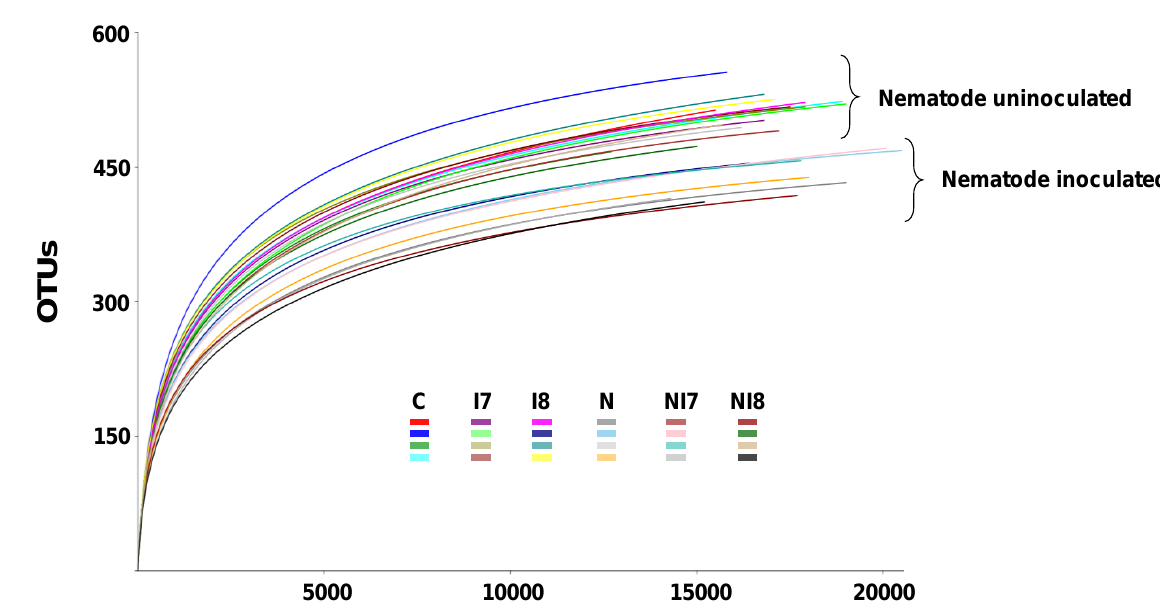
Figure 2. Operational taxonomic unit (OTU) rarefaction curves of the 16S rRNA sequence reads obtained revealing satisfactory sequencing depth to represent the pine rhizosphere and soil microbiota. C, negative control; I7, samples treated with Pseudomonas koreensis IRP7; I8, samples treated with Lysobacter enzymogenes IRP8; N, nematode-inoculated; NI7, nematode-inoculated samples treated with P. koreensis IRP7; NI8, nematode-inoculated samples treated with L. enzymogenes IRP8.